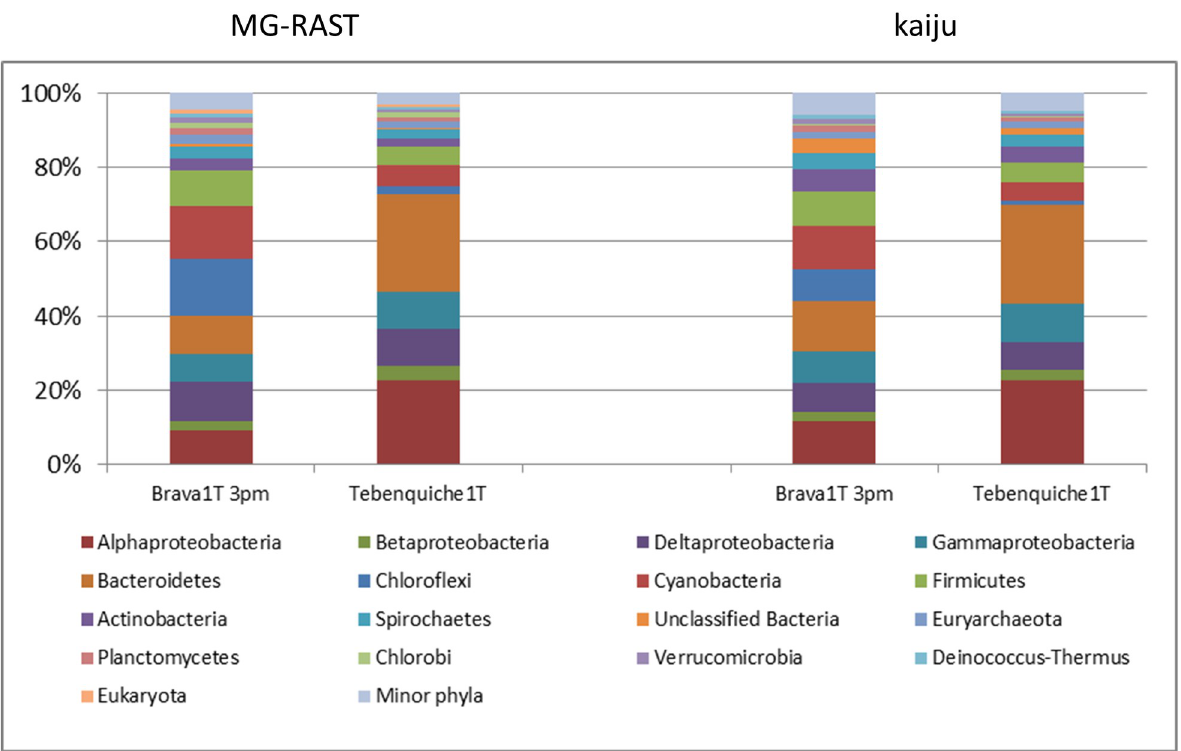
Fig 2. Taxonomic abundance at phylum level on each mat. Annotations based on MG-RAST or kaiju (see Materials and Methods for details). Proteobacteria were annotated at class level.